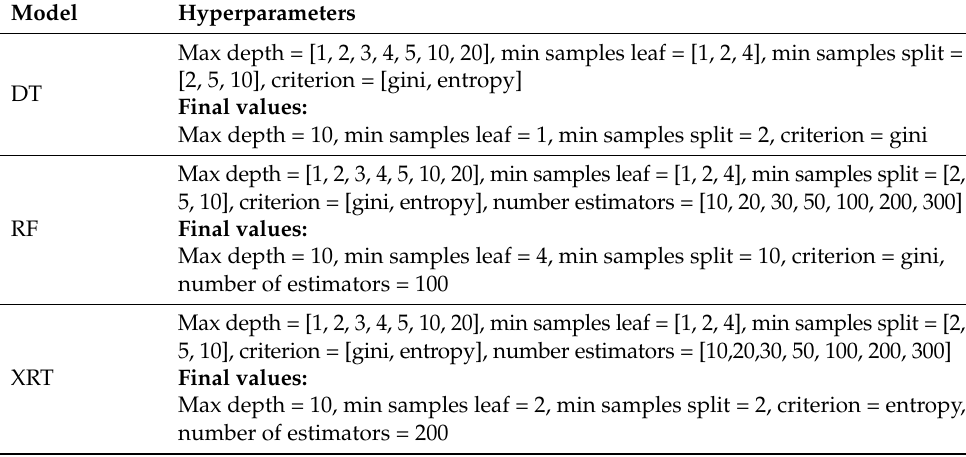
Table 4. Embedding model